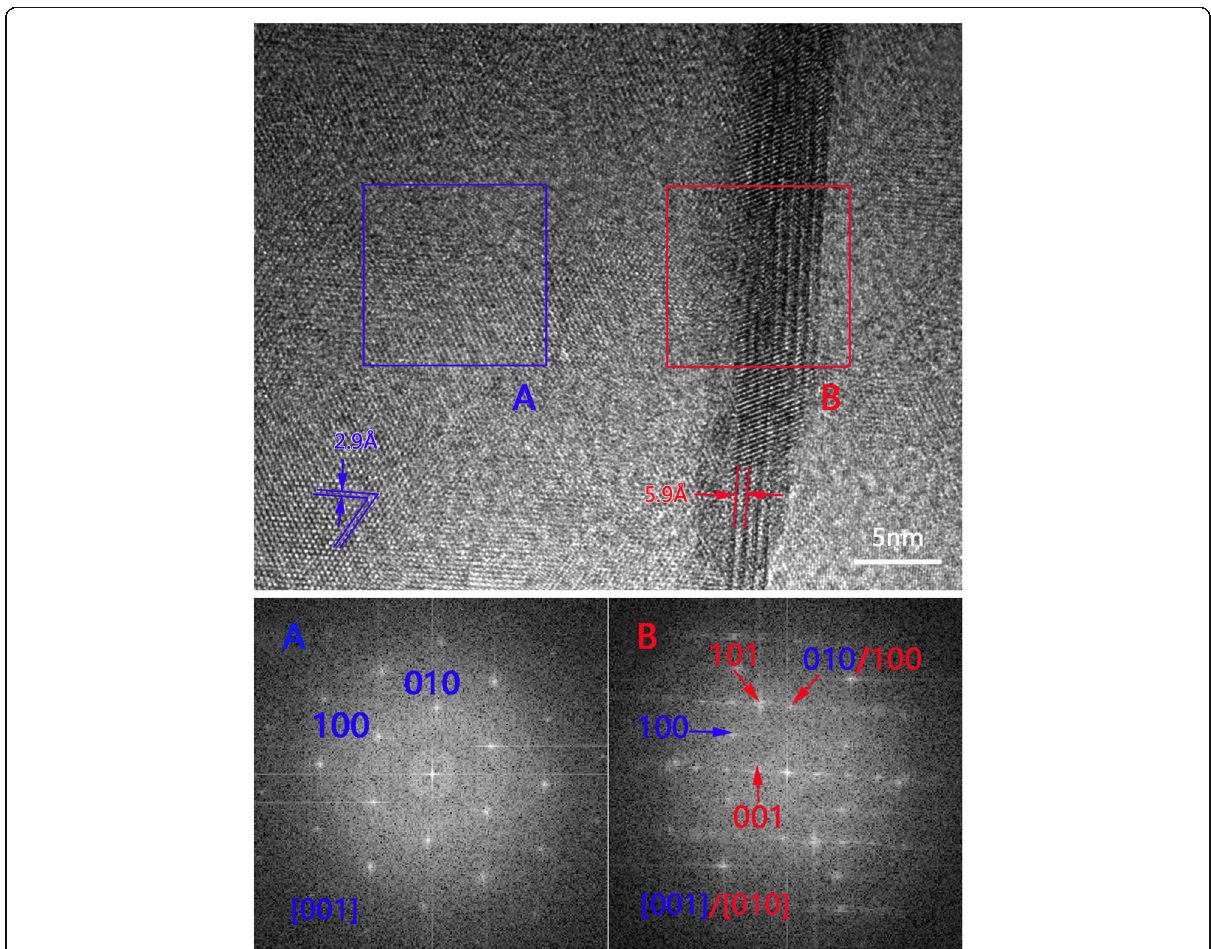
Fig. 5 Characterization of few-layer TaS 2 . HRTEM image of crisscross structure and FFT pattern of A and B regions. A is predictable [001] zone axis TaS 2 nanosheet, while B is concurrence of [001]/[010] zone axis. Among this, 101 and 001 spots of 1T-TaS 2 are